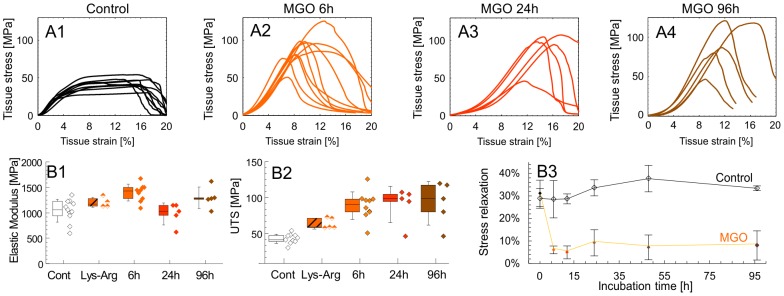
Mechanical characterization of the tendon-AGE model.
Row A: Stress-strain from the first experimental set. Except for the MGO 96 h group, these curves were measured simultaneously with the SAXS experiments. Row B: A selection of material properties extracted from row A: B1) Elastic modulus was obtained in the linear range. Given are: mean (horizontal bar), percentile box (25% and 75%) and ±1 SD. The specificity of the MGO treatment was shown by the addition of L-lysine and L-arginine (LYS-ARG group) to the MGO solution and compared to MGO controls. For ease of reading this control is not shown. B2) Ultimate tensile strength (UTS). B3) Separate stress relaxation experiment (n = 5) was performed with repeated measurements on the same samples and compared to a corresponding control (n = 5). Stress relaxation is reported as: σ
R(175 s) = 1-σ(175 s)/σ(0 s) [%].